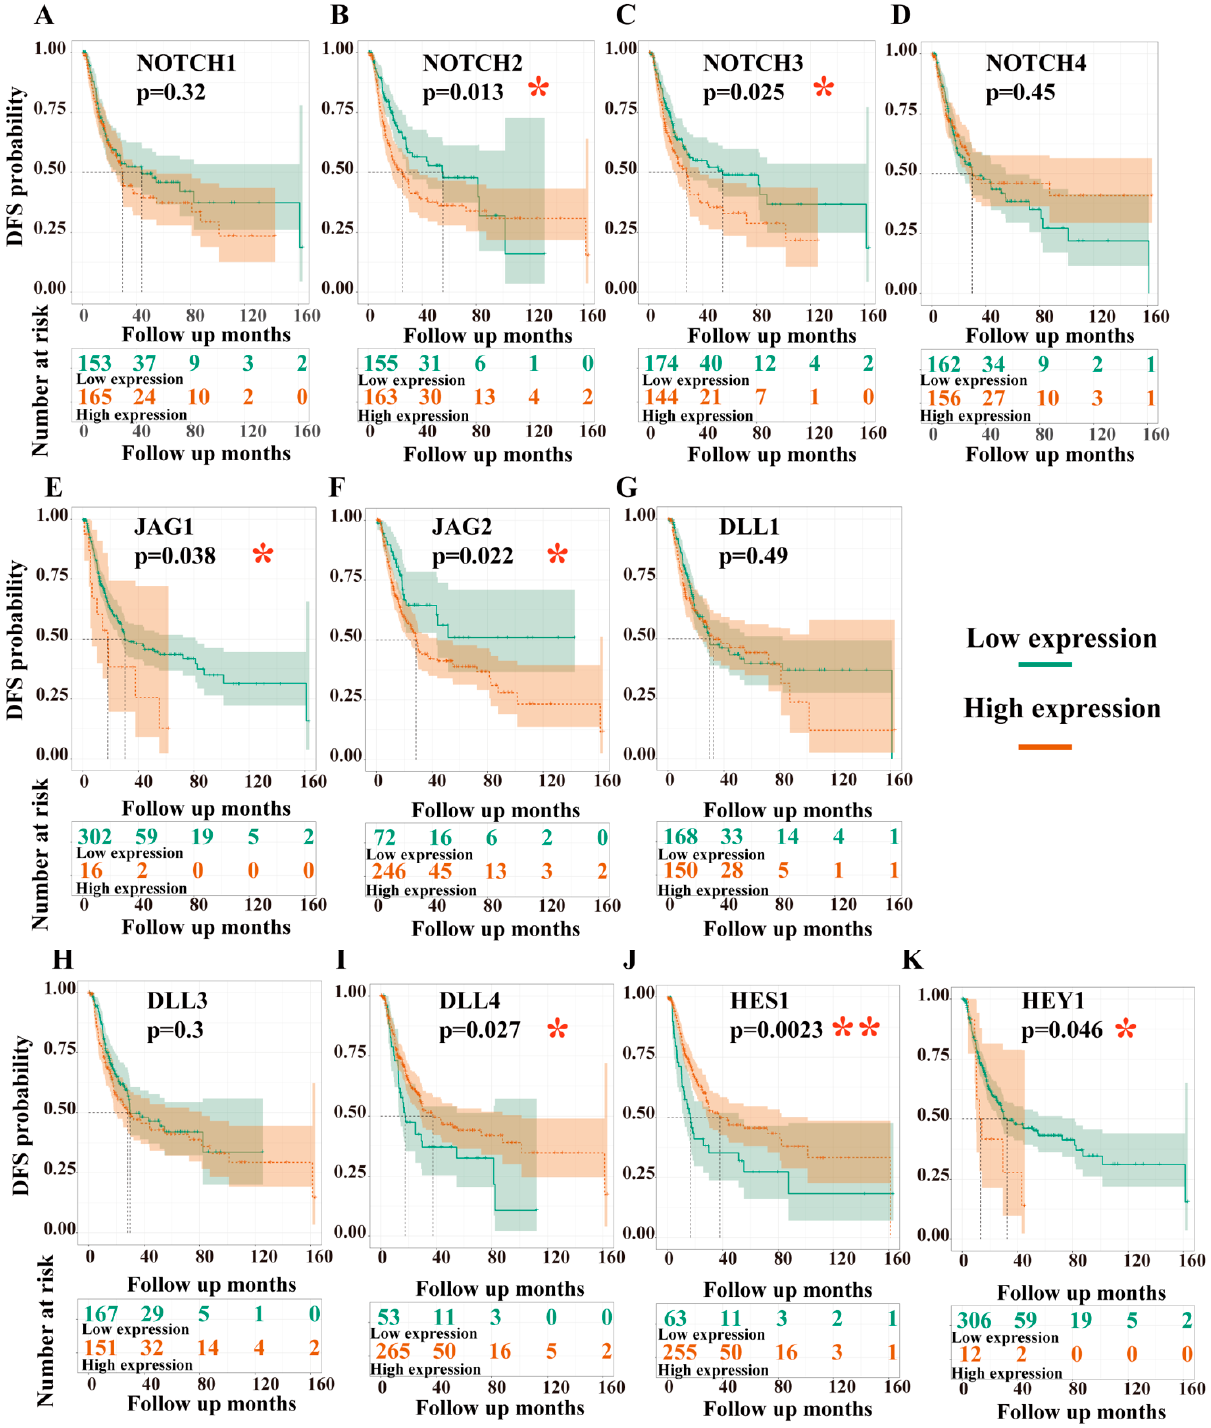
Figure 7. DFS analyses of the target genes. NOTCH1 ( A ), NOTCH2 ( B ), NOTCH3 ( C ), NOTCH4 ( D ), JAG1 ( E ), JAG2 ( F ), DLL1 ( G ), DLL3 ( H ), DLL4 ( I ), HES1 ( J ), and HEY1 ( K ). Data from TCGA-BLCA, n = 406; recurrence, n = 141; no recurrence, n = 177. The threshold (cut-off value) used to define the high or low levels of the expression groups are listed in Table S6. y -axis = DFS probability, x -axis = follow up days; high expression is marked with an orange line, low expression is marked with a green line. The number at risk in high- and low-expression groups are listed in the tables below the survival curve; significance levels are marked as * p -value ( p ) < 0.05, ** p -value < 0.01. Table 5. Risk assessment of Notch components on DFS.